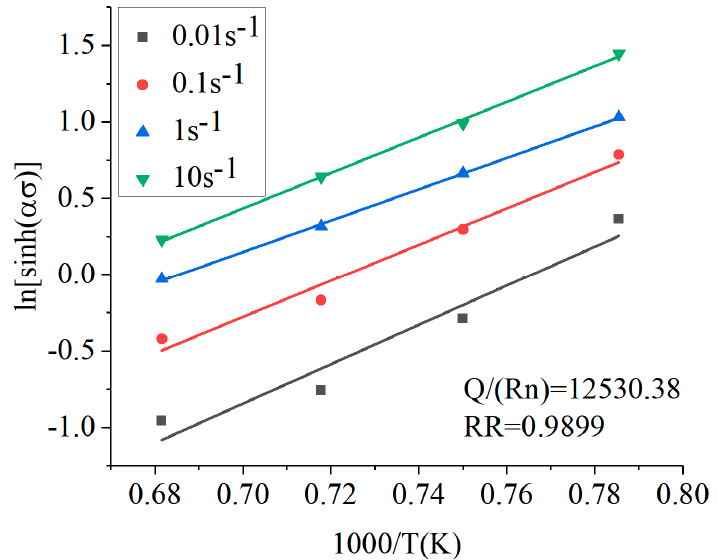
Figure 5. The linear relationships of 1000/T and ln[sinh( ασ )].